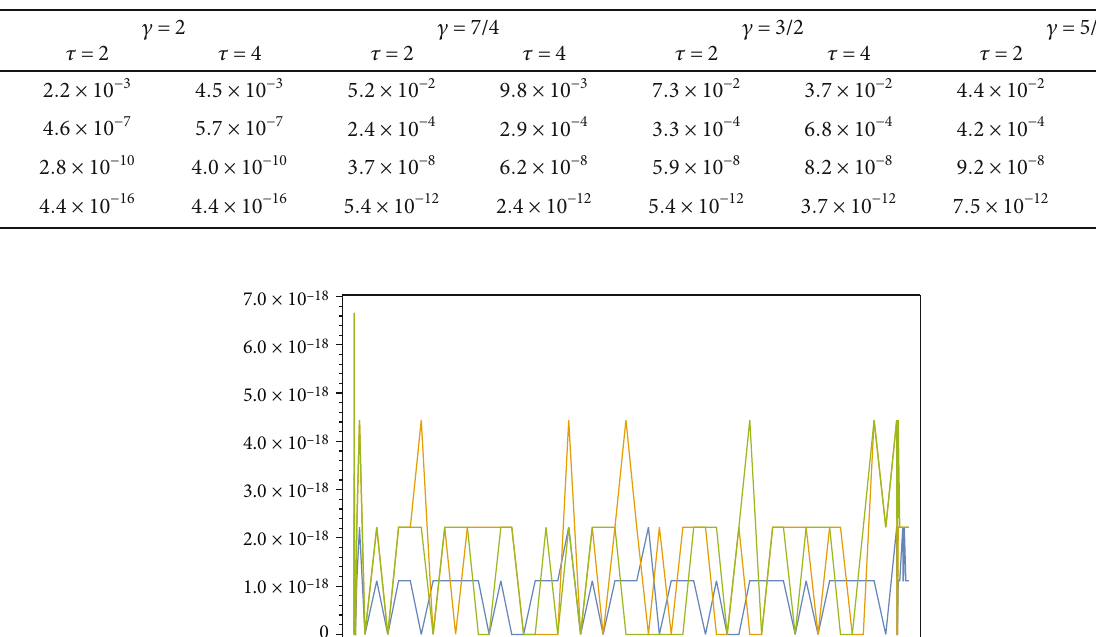
for various values of γ , for example 4. n